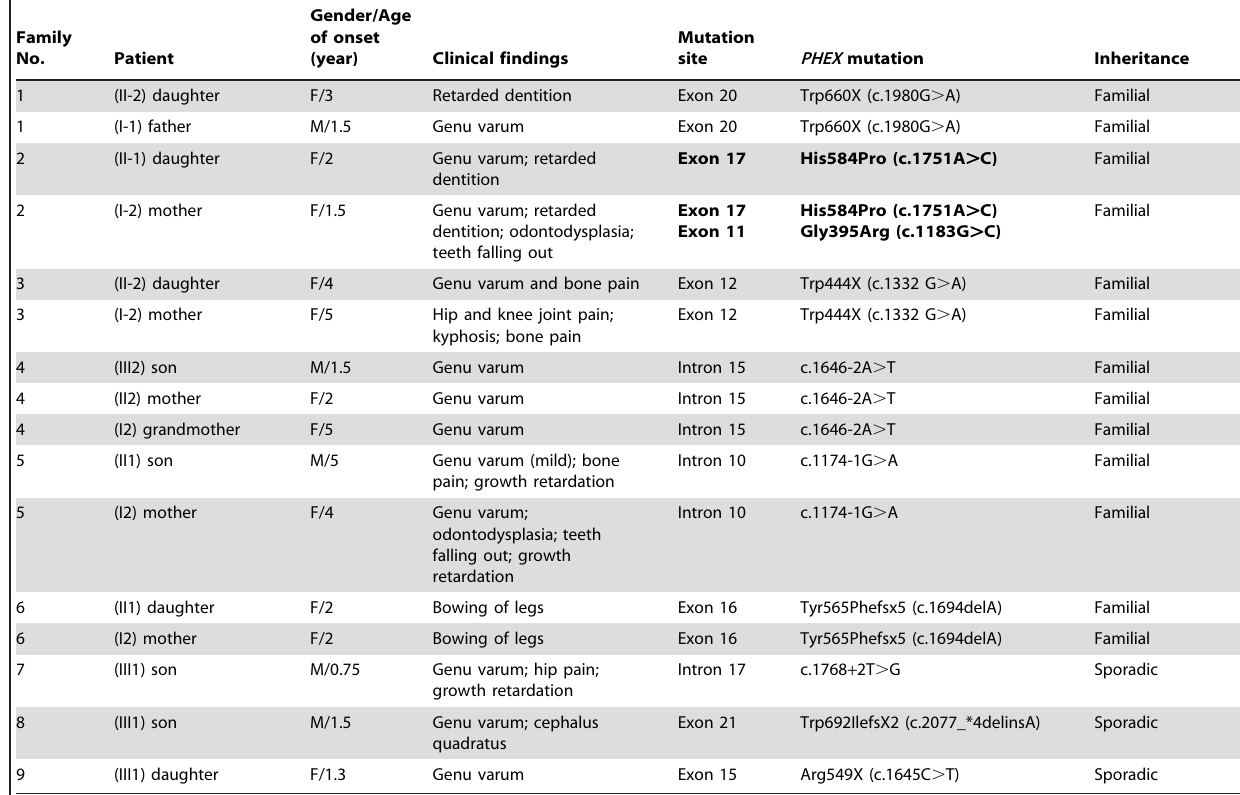
Table 2. Summary of the patient clinical data.